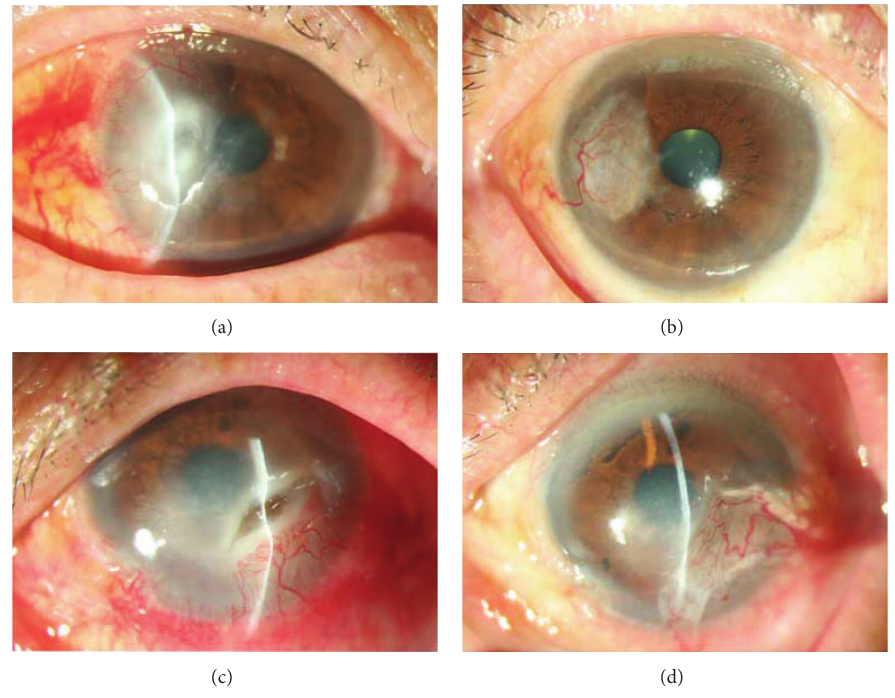
Figure 1: Slit-lamp photographs showing the treatment course of severe herpes simplex virus necrotizing stromal keratitis. (a) Patient 1: the preoperative UCVA was 20/200. The average size of ulcers approximately 4mm × 5 mm. The depth of the corneal ulcer typically exceeds fifty percent of the entire cornea. Evident corneal necrosis can be seen in the surrounding stromal edema. (b) 12 months after single-pedicle conjunctival flap transplantation, the cornea ulcer was completely cured. The central cornea was clear. The patient had UCVA 20/25 and BSCVA 20/20. (c) Patient 2: the preoperative UCVA was 20/400. Conjunctival hyperemia was observed. The average of the ulcer on the infranasal side of the cornea was about 6mm × 3 mm. The corneal OCT revealed that the ulcer had nearly reached Descemet’s membrane. The surrounding tissue displayed necrosis, infiltration, and edema. (d) 18 months after double-pedicle conjunctival flap transplantation, the corneal ulcer had healed, with the relief of corneal edema, UCVA was 20/63, and BSCVA was 20/32.